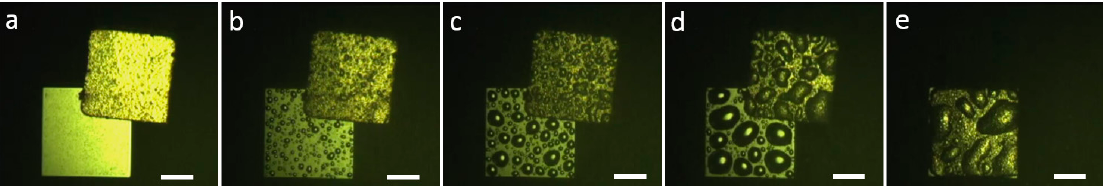
Figure 9. Mist capillary self-alignment: ( a ) a 500 μ m × 500 μ m × 300 μ m chip landed on a receptor site with an initial placement error; ( b ) water mist was delivered to the assembly site; ( c , d ) microscopic droplets accumulated at the assembly site; and ( e ) the chip was self-aligned with the corresponding receptor site (Supplementary Video S1). Scale bar: 200 μ m.